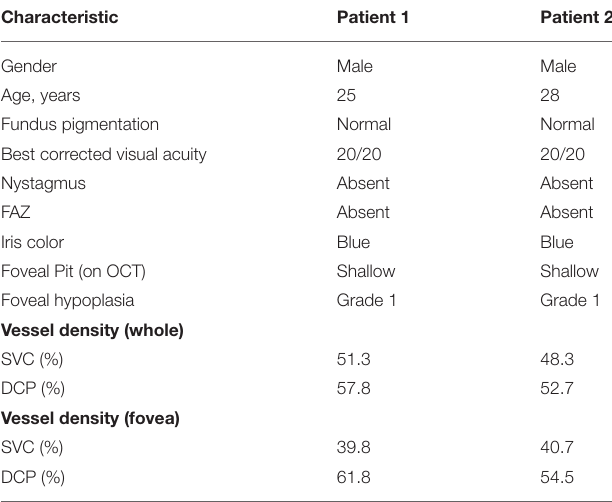
TABLE 1 | Clinical findings in subjects with fovea